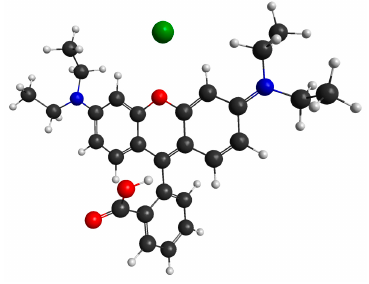
Figure 4. Molecular structure of the Rhodamine-B thermochromic dye.